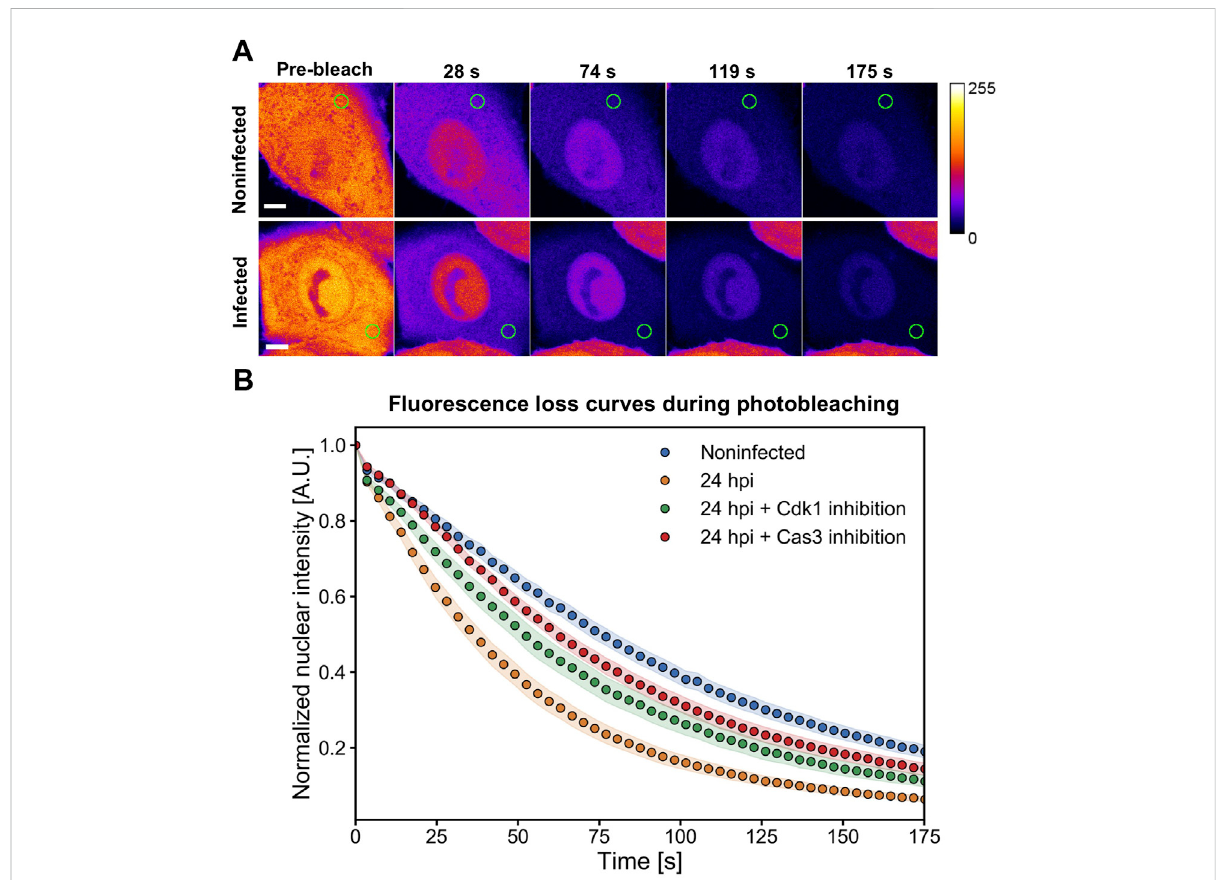
FIGURE 2 Nuclear envelope permeability is increased in infection and restored upon exposure to Cdk1 and caspase inhibitors. FLIP analyses of nuclear envelope permeability in infected cells at 24 hpi. (A) Infected and non-infected NLFK cells stably expressing EGFP were photobleached in the cytoplasm as indicated by the green circle. The fl uorescence images before photobleaching (time = 0 s) and four different time points during photobleaching areshown. A calibrationbar forpseudocoloringisshown. Scalebars, 5 µm. (B) Nuclearenvelope permeabilityofinfectedcells at 24 hpi in the presence and absence of inhibitors of Cdk1 (RO-3306) and apoptosis (caspase 3 inhibitor). Quanti fi cation of fl uorescence loss at the nucleoplasmic region of interest during a 175 s period of continual photobleaching of the cytoplasm. The fl uorescence loss curves showing the relative fl uorescenceintensityarepresentedfornon-infecteduntreatedcontrolcells(blue)( n =12),infectedcells(orange)( n =17),andinfectedcells in the presence of Cdk1 (red) ( n = 13), and caspase 3 (green) ( n = 14) inhibitors. The shaded areas around the data points represent the standard error of the